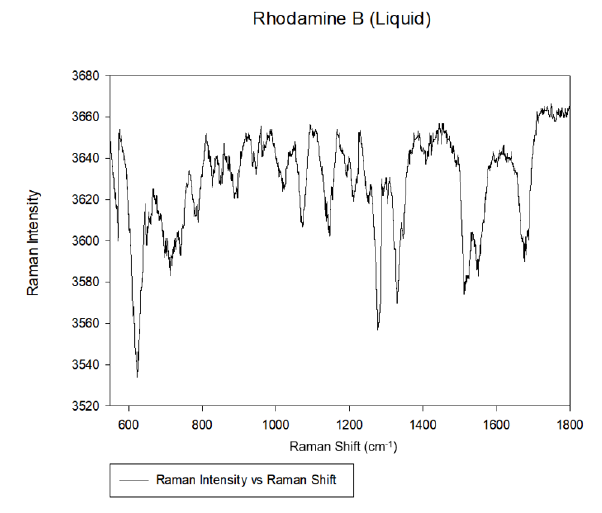
Fig. 7. Upside down Raman spectrum of Rhodamine B liquid